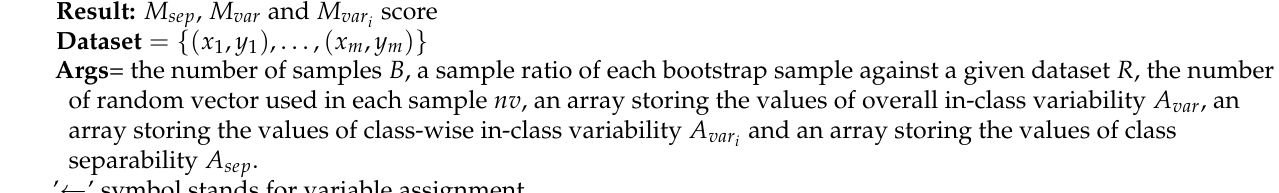
Algorithm 1: Algorithm of class separability and in-class